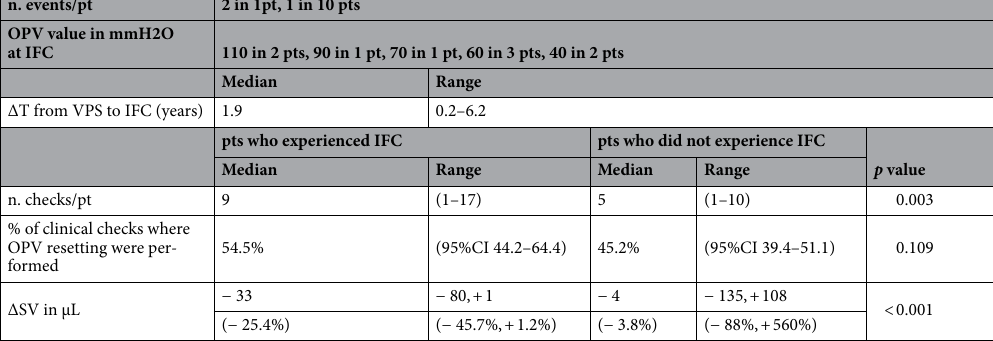
n. events/pt 2 in 1pt, 1 in 10